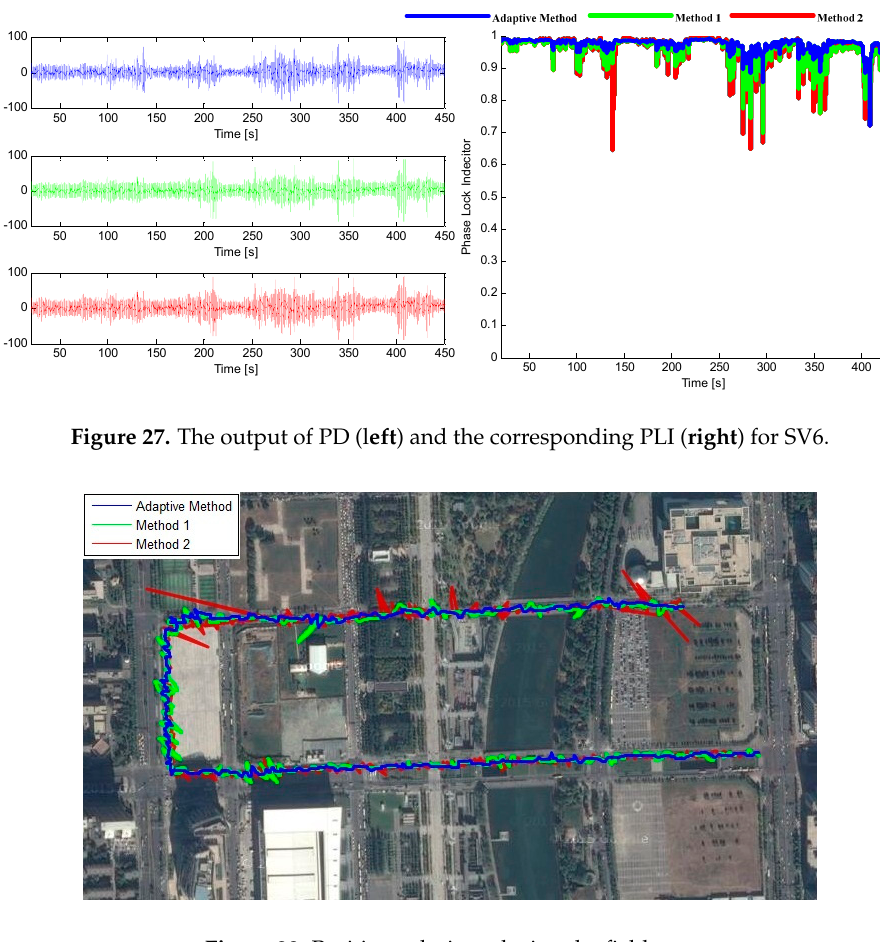
Figure 28. Position solutions during the field test.